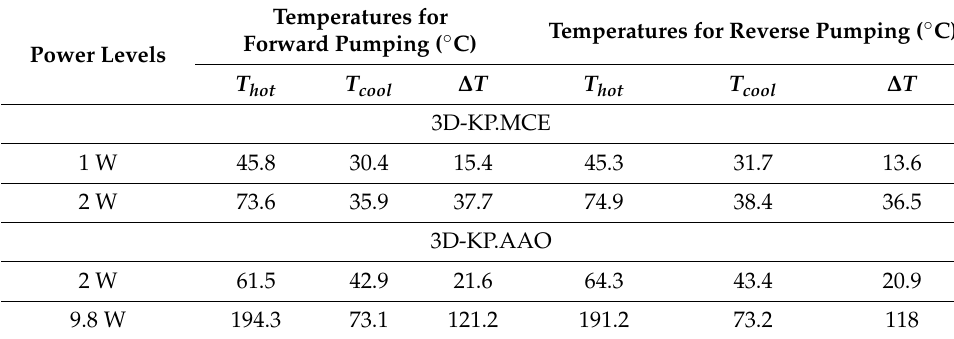
Table 3. Measured temperatures for 3D-KPs.